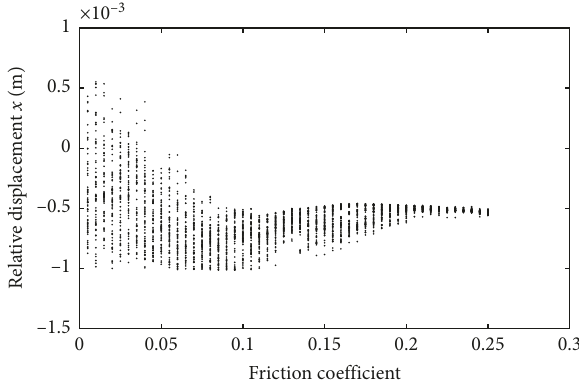
Figure 16: Bifurcation diagram with varying friction